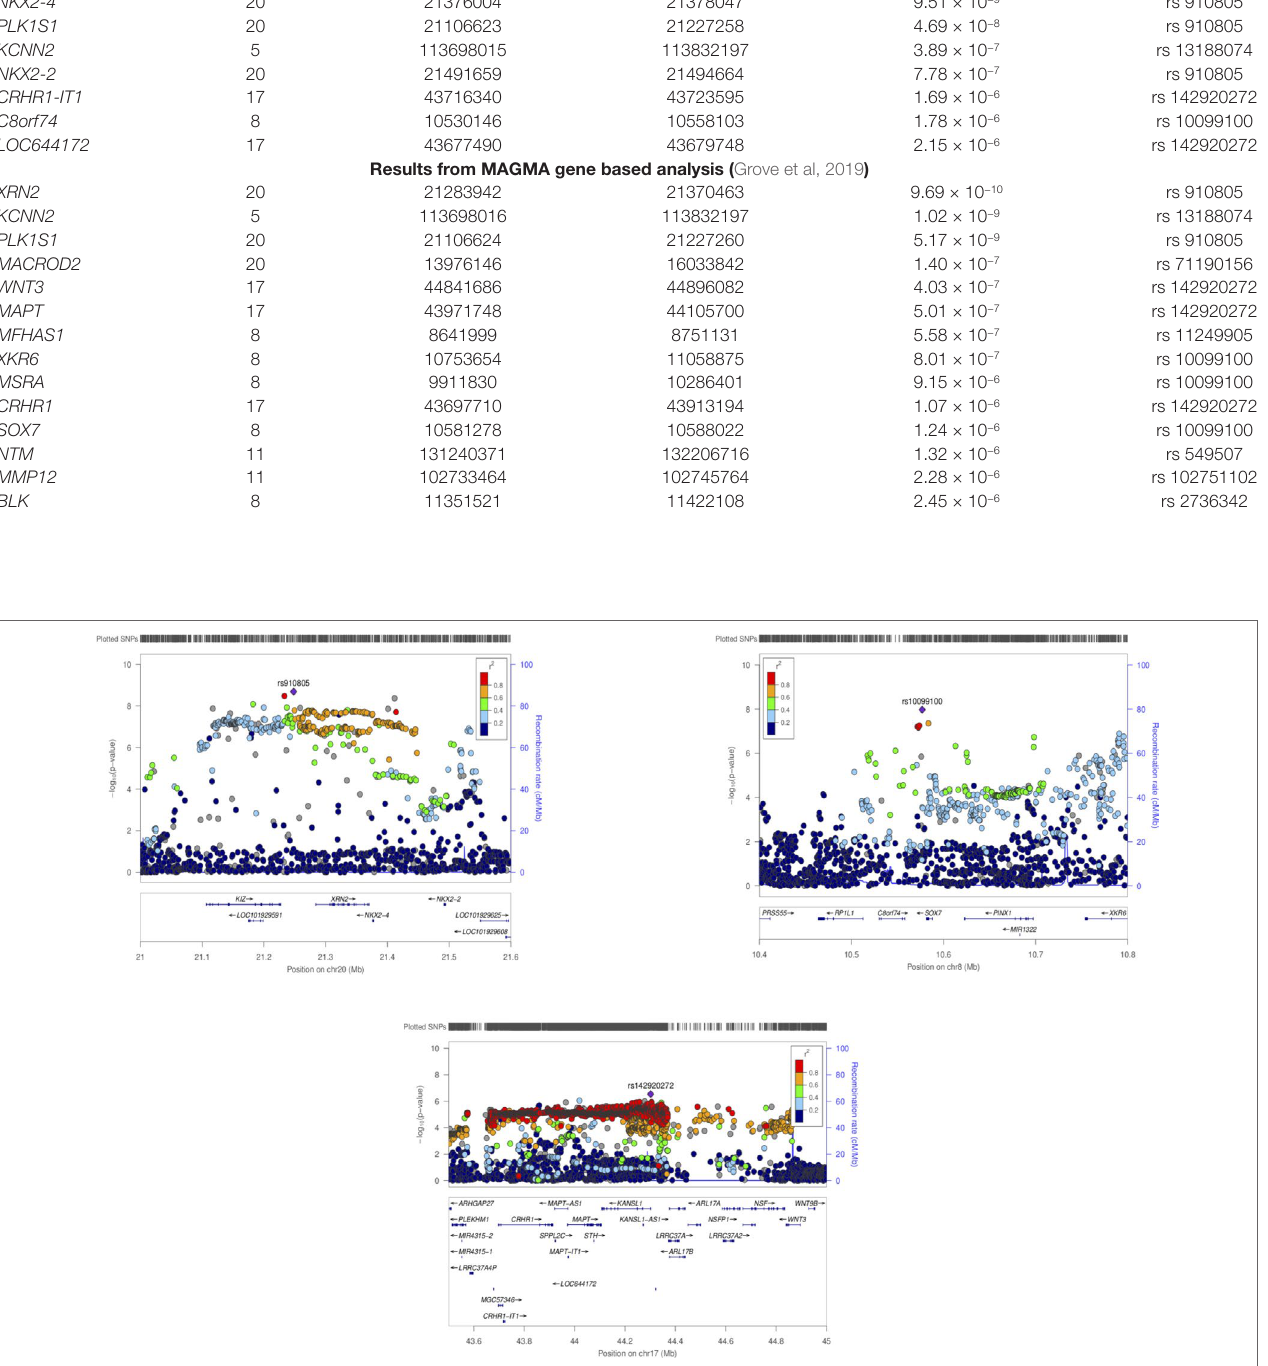
FIGURE 1 | Regional association plots for ASD GWAS meta-analysis (chromosomes 20, 8 and 7). PASCAL has highlighted associations at a gene level for NKX2 -2 and NKX2-4 (chr20), CRHR1-IT1 , LOC644172 (chr17), and C8orf74 (chr8) among other genes previously associated by